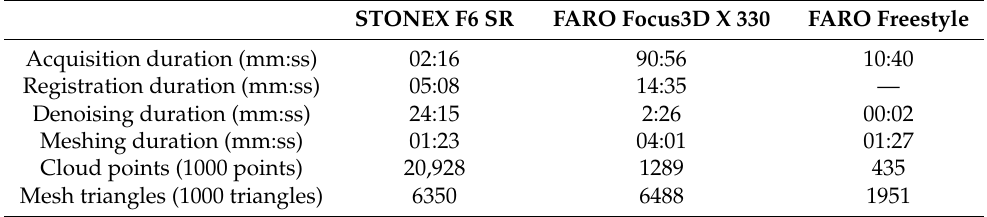
Table 9. Scanning results, capital replica.